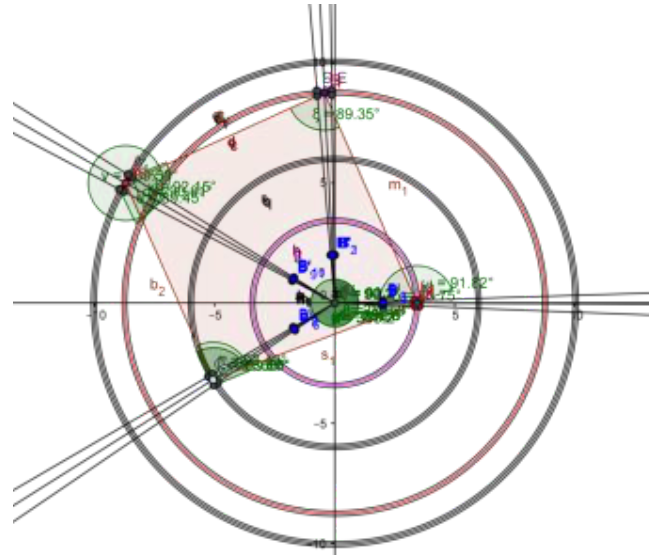
Figure 9: The geometric loci of each corner of a room as a function of all the measurements